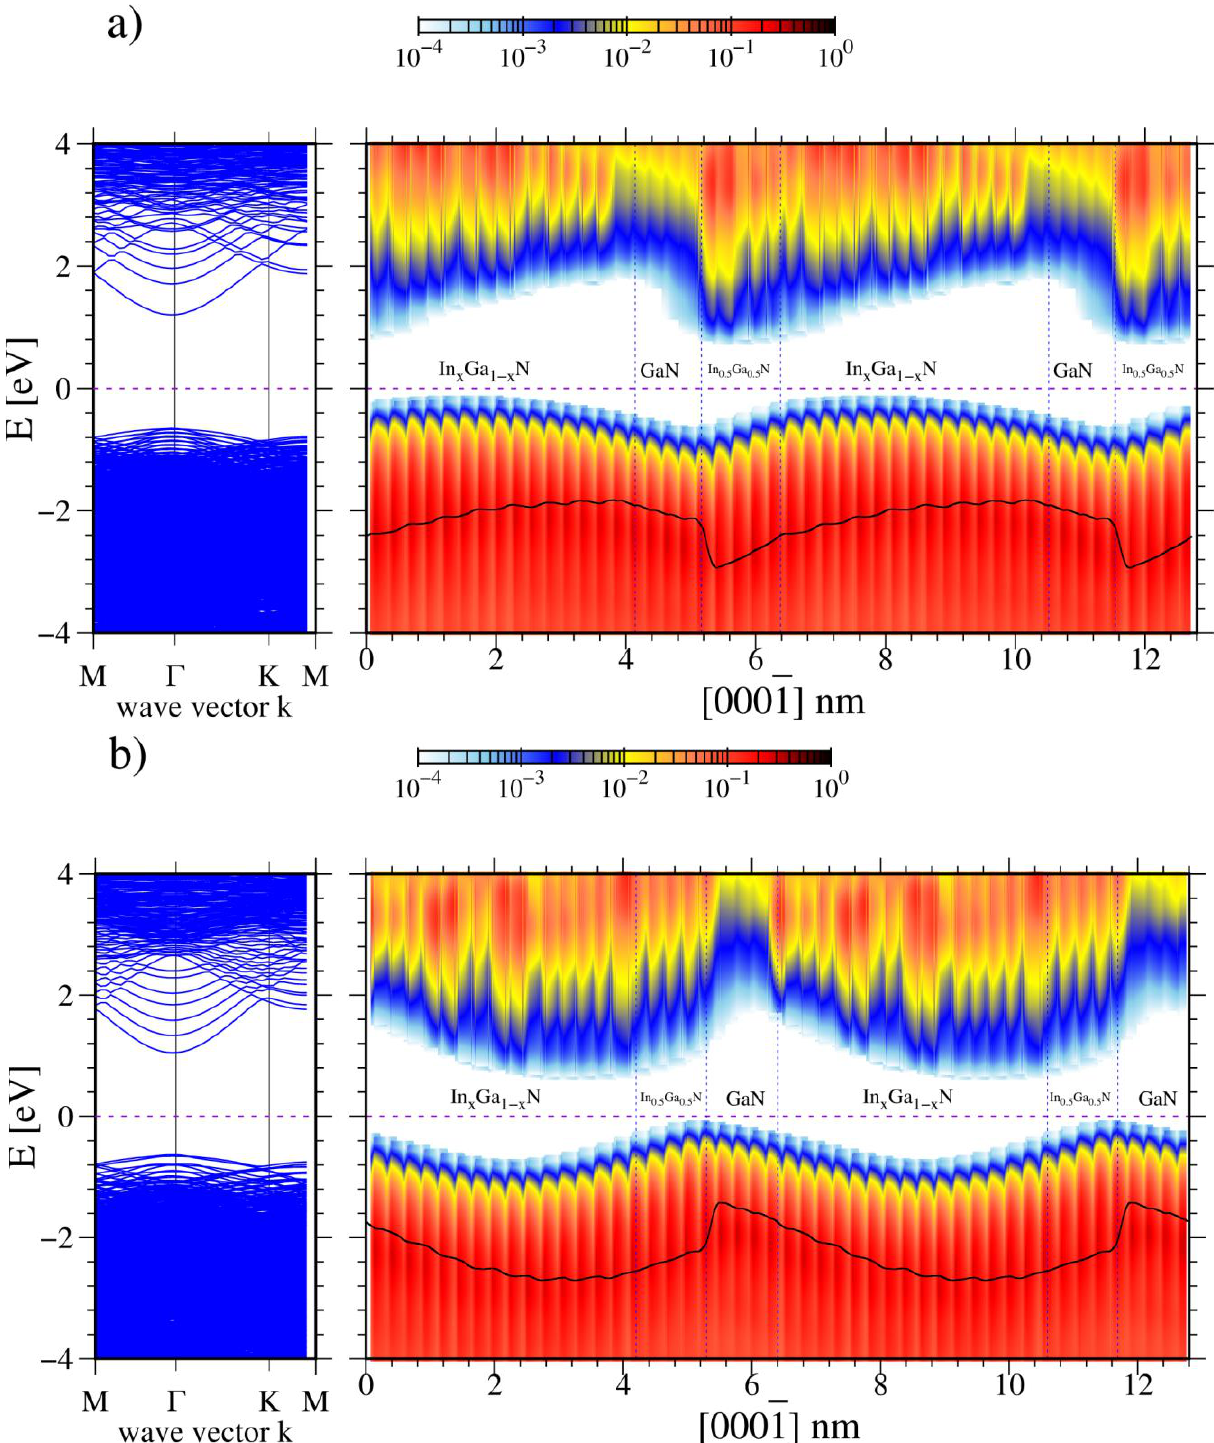
Figure 5. Band profiles of the lattices presented in ( a , b ) These diagram show: left panel — energy bands in the momentum space, right panel — energy bands in the coordination space. The color at the top gives the scale of the density of states. The black line that is superimposed on the valence band represents the averaged potential multiplied by the electron charge.